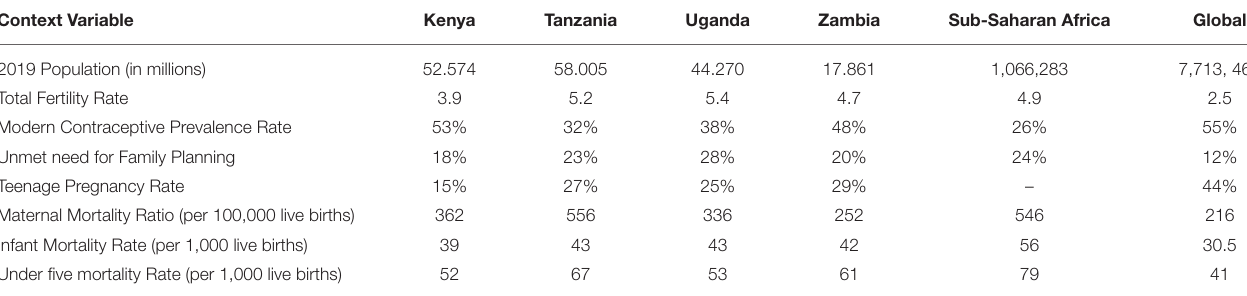
TABLE 1 | Comparison of SRH indicators for Kenya, Tanzania, Uganda and Zambia (4–8). Context